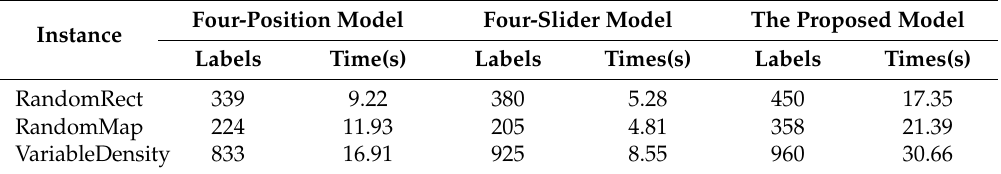
Table 4. The labeling results and running time for the three